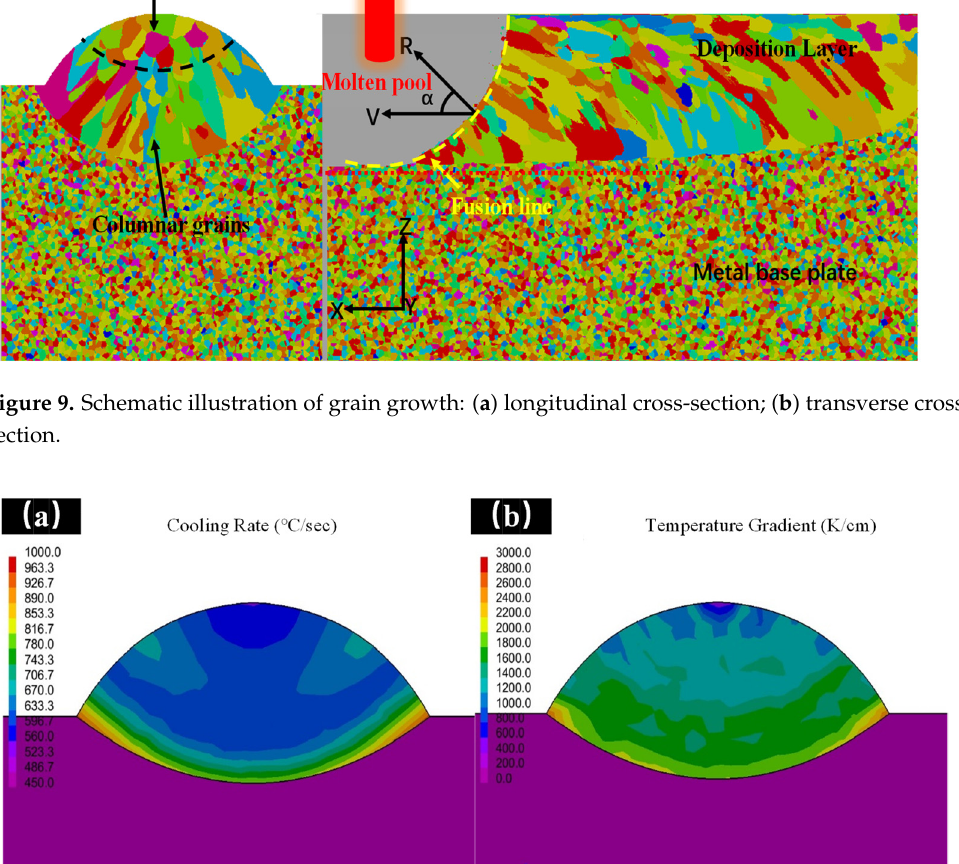
10 of 16 Figure 8. Comparison between simulated and experimental thermal cycle curves. 4.2. Microstructure Analysis and Verification